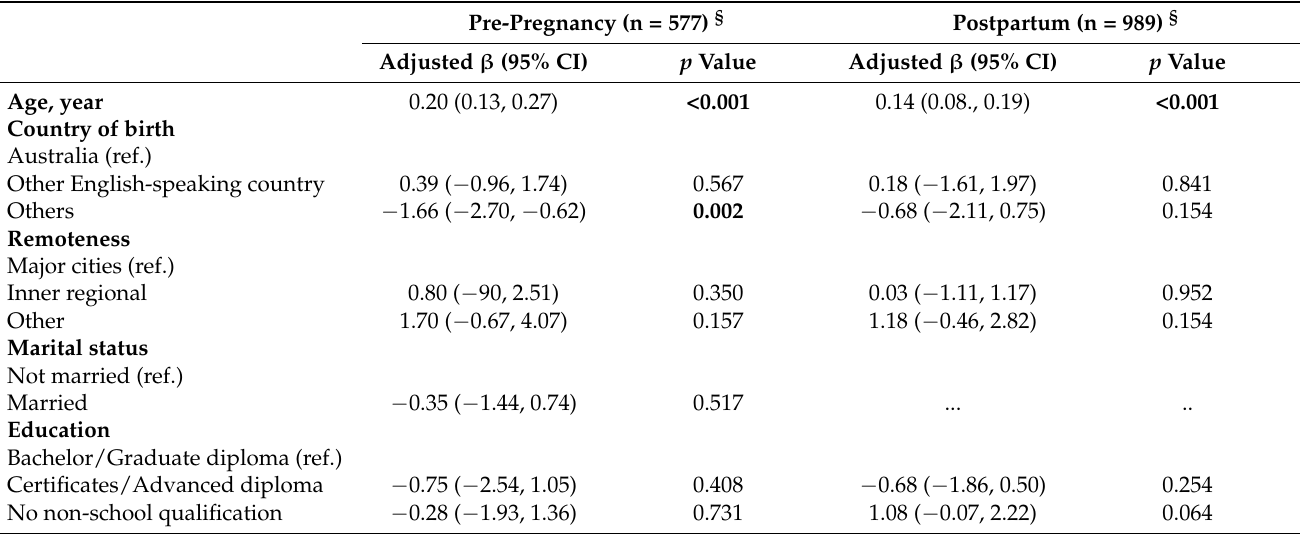
Table 6. Sensitivity analysis of the associations between diet and physical activity and BMI after excluding implausible energy reporters among pre-pregnant and postpartum